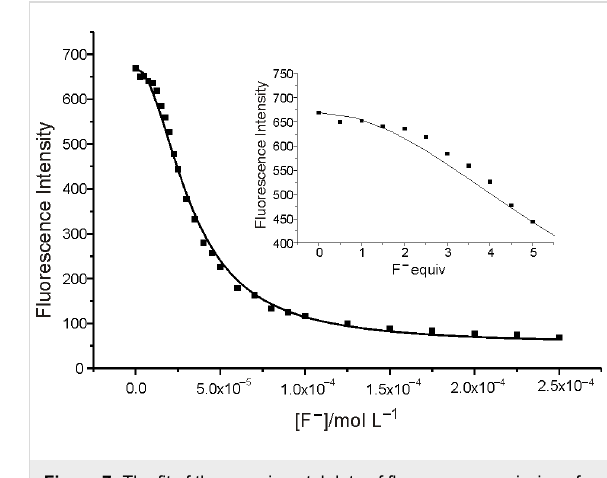
Figure 7: The fit of the experimental data of fluorescence emission of 1 (5 μ M) upon the addition of F − at 400 nm to a 1:2 binding profile (excited at 340 nm). Inset: the partial enlarged curve when less than 5 equiv of F − was added.